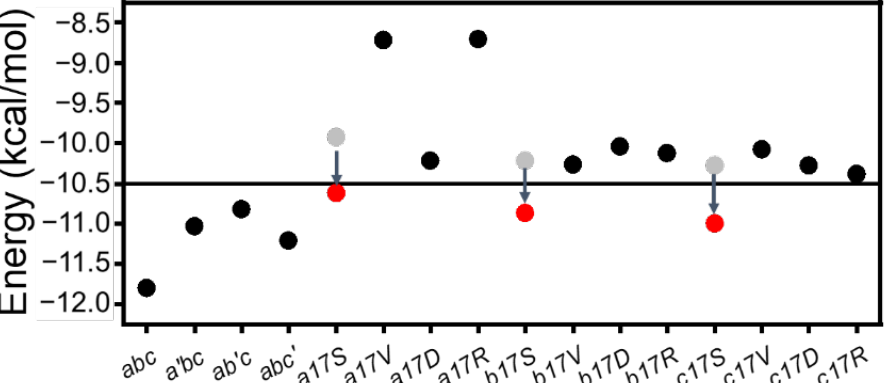
Figure 8. E HB of 2 G–X–Y regions. The E HB of the six main-chain H-bonds are represented by gray and black dots, and the local energy of the Ser mutant changes from gray to red after the compensation effect.